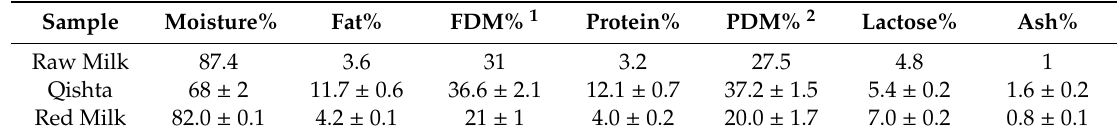
Table 1. Chemical composition of raw milk, Qishta and red